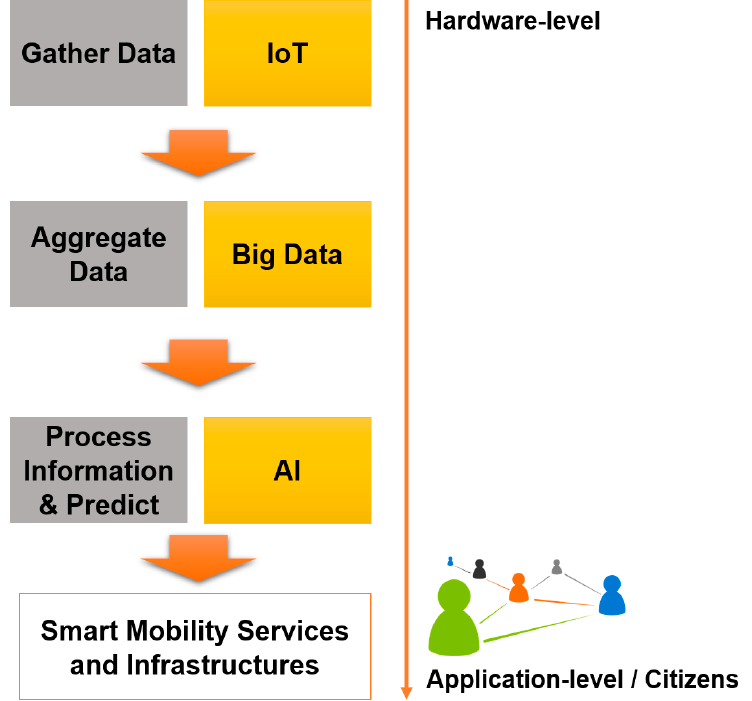
Figure 10. Contribution of some of the enabling technologies to smart